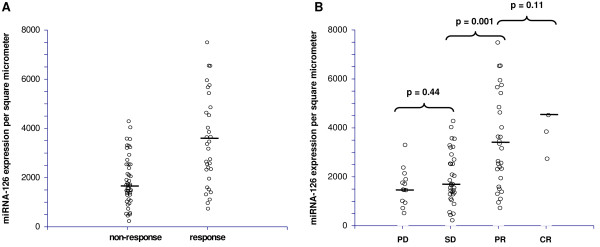
Relationship between miRNA-126 and response. (A) Distribution of miRNA-126 expression levels according to response or non-response to first line XELOX in patients with mCRC, black bars represent the medians, n = 83. The difference between the medians in the two groups was significant, p = 0.000005. (B) Illustration of the same distribution divided into the four response groups (PD; progressive disease, SD; stable disease, PR; partial response and CR; complete response). A significant difference between the median miRNA-126 expression levels in the patients achieving SD compared to PR was observed, p = 0.001. The miRNA-126 expression levels from five patients (outliers, levels ranging from 16775-40284) are not shown in the figures for graphical reasons only, but were included in the statistics. Two of these patients achieved PR and the remaining three CR.